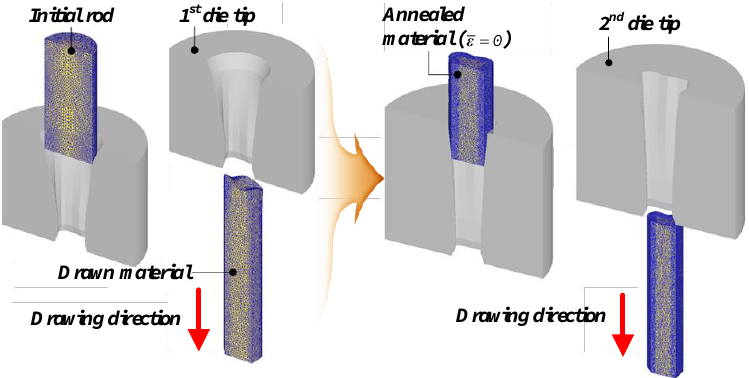
Figure 10. FE model of the shape-drawing process for the cross-roller guide. The total reduction area (RA) is 59.3% of the cross-roller guide. The RA of the first pass and the second pass is 34% and 38.5%, respectively, in the case of the ERV method. The RA of the first pass and the second pass is 36.3% and 36.3%, respectively, in the case of the equipotential line method.